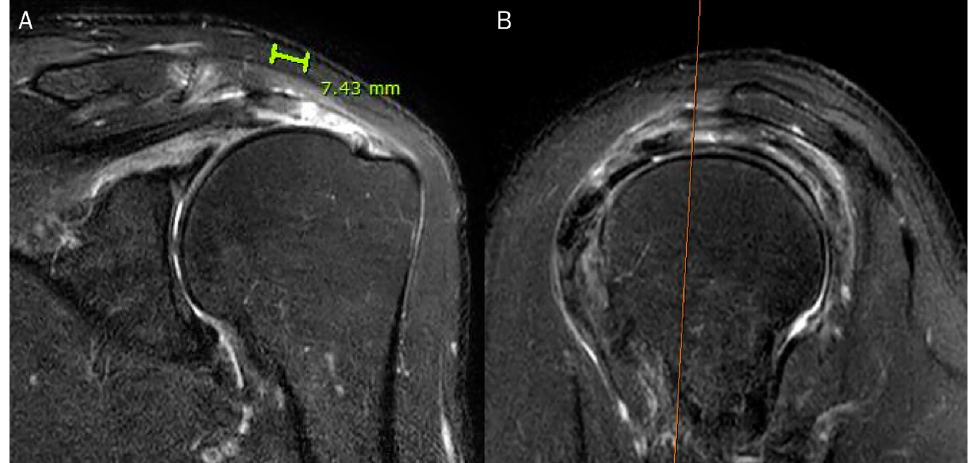
Figure 7. Arthroscopically proven full-thickness tear of the supraspinatus tendon without delamination. ( A ) Oblique coronal fat-suppressed T2-weighted image and ( B ) coronal fat-suppressed T2-weighted image demonstrate the full-thickness tear of the supraspinatus tendon with a visible cleavage measured at least 1 cm in length. The tendon was not classified as a delaminated tear.